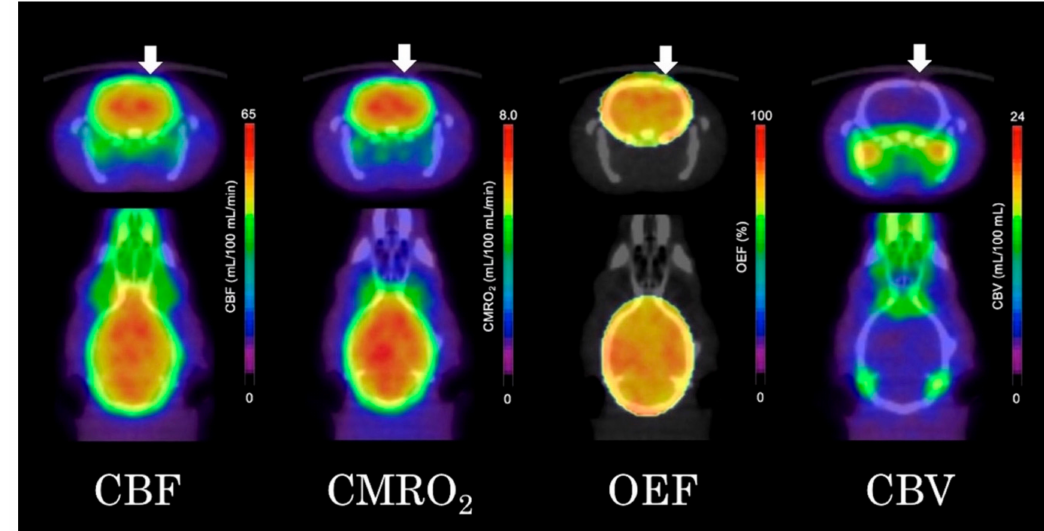
Figure 4. Quantitative 15 O-gas positron emission tomography (PET) images of the cerebral blood flow (CBF), cerebral metabolic rate of oxygen (CMRO 2 ), oxygen extraction fraction (OEF) and cerebral blood volume (CBV) (arrows indicated the ipsilateral side of the fluorocitrate (FC) injection).